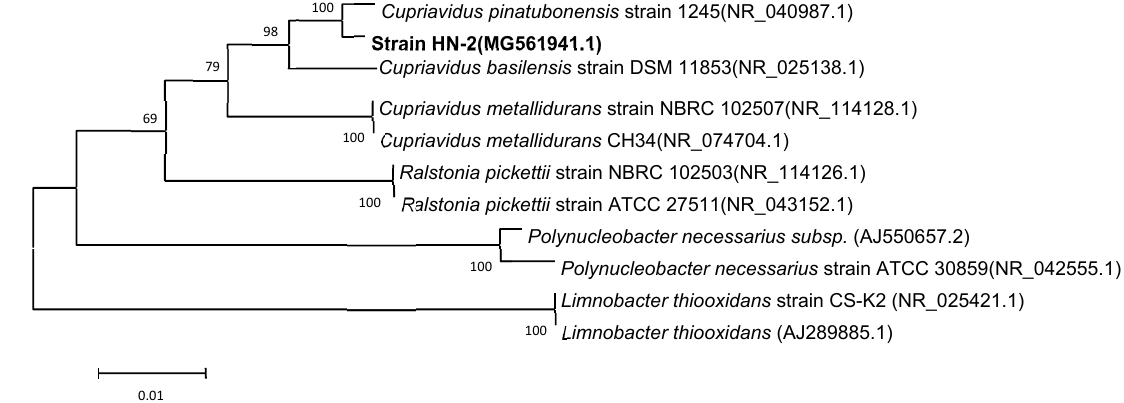
Figure 3. Phylogenetic tree based on the 16S rDNA sequence of Cupriavidus sp. strain HN-2 (represented in bold) and related strains. Numbers in parentheses represent the sequence accession numbers in GenBank. Numbers at the nodes indicate the bootstrap values from neighborhood-joining analysis of 1000 re-sampled data sets. Bars represent sequence